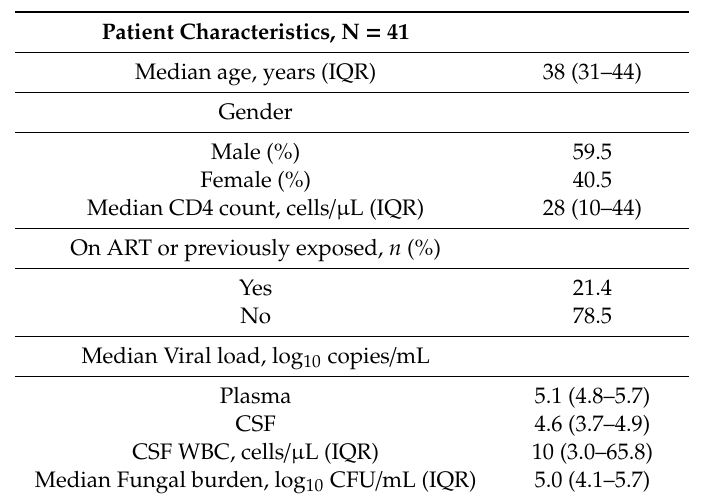
Table 1. Baseline characteristics and demographics of the 41 study